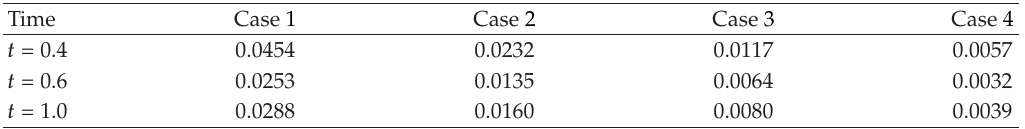
Table 1: L 2 -norm estimates of U n − u n .